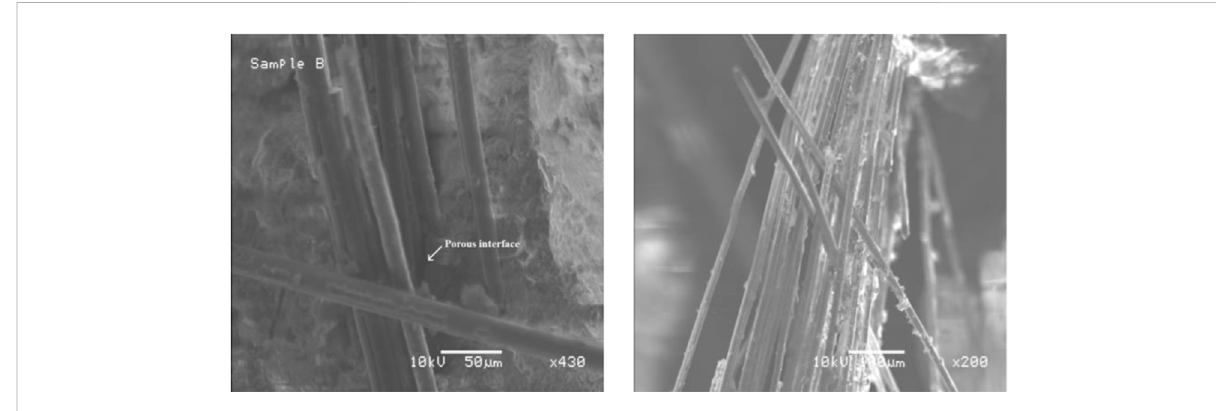
FIGURE 4 SEM images of fractured cement paste and fi bre surface at 3d.